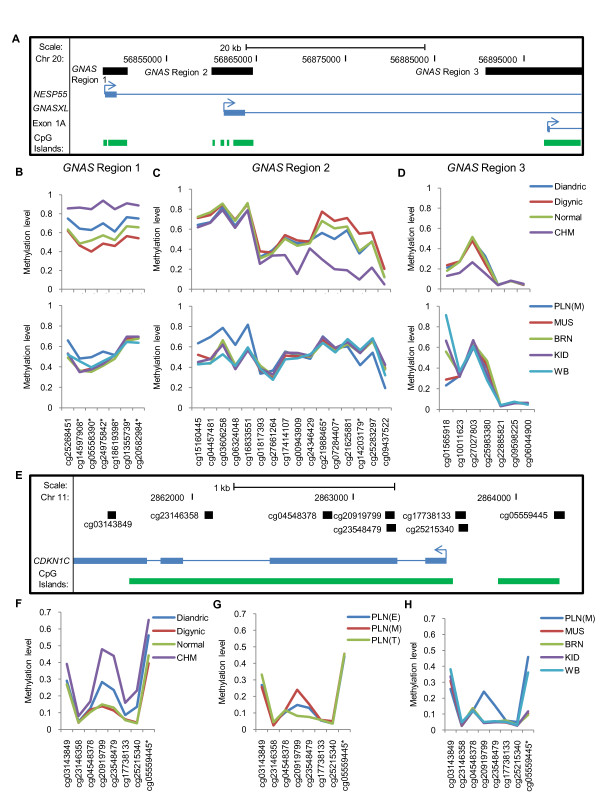
Illustration of tissue-specific and gestational age-specific methylation at the proximal promoter regions of GNAS and CDKN1C. (A) and (E) Schematics showing the positions of the Illumina Infinium probes relative to the genes and transcripts. Arrow directions represent the transcriptional directions for the genes or transcripts. Genomic coordinates were retrieved from the UCSC Genome Brower database (hg18). (B) through (D) Average methylation levels of the Illumina Infinium probes in different placental groups (top) and in different tissues (bottom). Probe numbers are shown on the x-axes in the bottom panels divided into (B) GNAS region 1, (C) GNAS region 2 and (D) GNAS region 3 according to their proximity to the known transcripts. Tissue-specific methylation can be found from cg15160445 to cg16833551 in GNAS region 2 and at cg01565918 in GNAS region 3. (F) through (H) Average methylation levels of the Illumina Infinium probes of CDKN1C in (F) different placental groups, (G) different gestational ages of placenta and (H) different tissues. Probe numbers are shown on the x-axes. Both tissue-specific and gestational age-specific methylation can be found at cg20919799. PLN(E): early gestation placenta; PLN(M): midgestation placenta; PLN(T): term placenta; MUS: muscle; BRN: brain; KID: kidney; WB: whole blood.